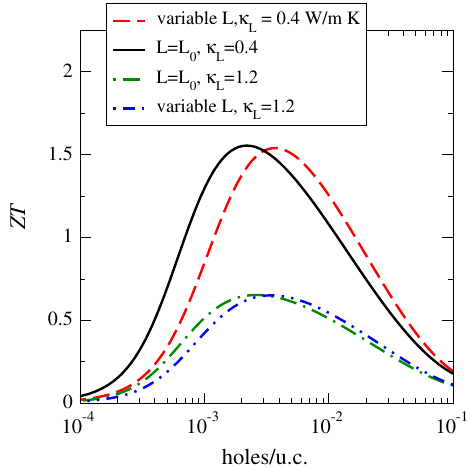
FIG. 8. The calculated figure-of-merit ZT for Bi 2 Se 3 at 500 K, for the indicated 500 K values of the lattice thermal conductivity, and with the free-electron Lorenz number as well as the first principles calculated